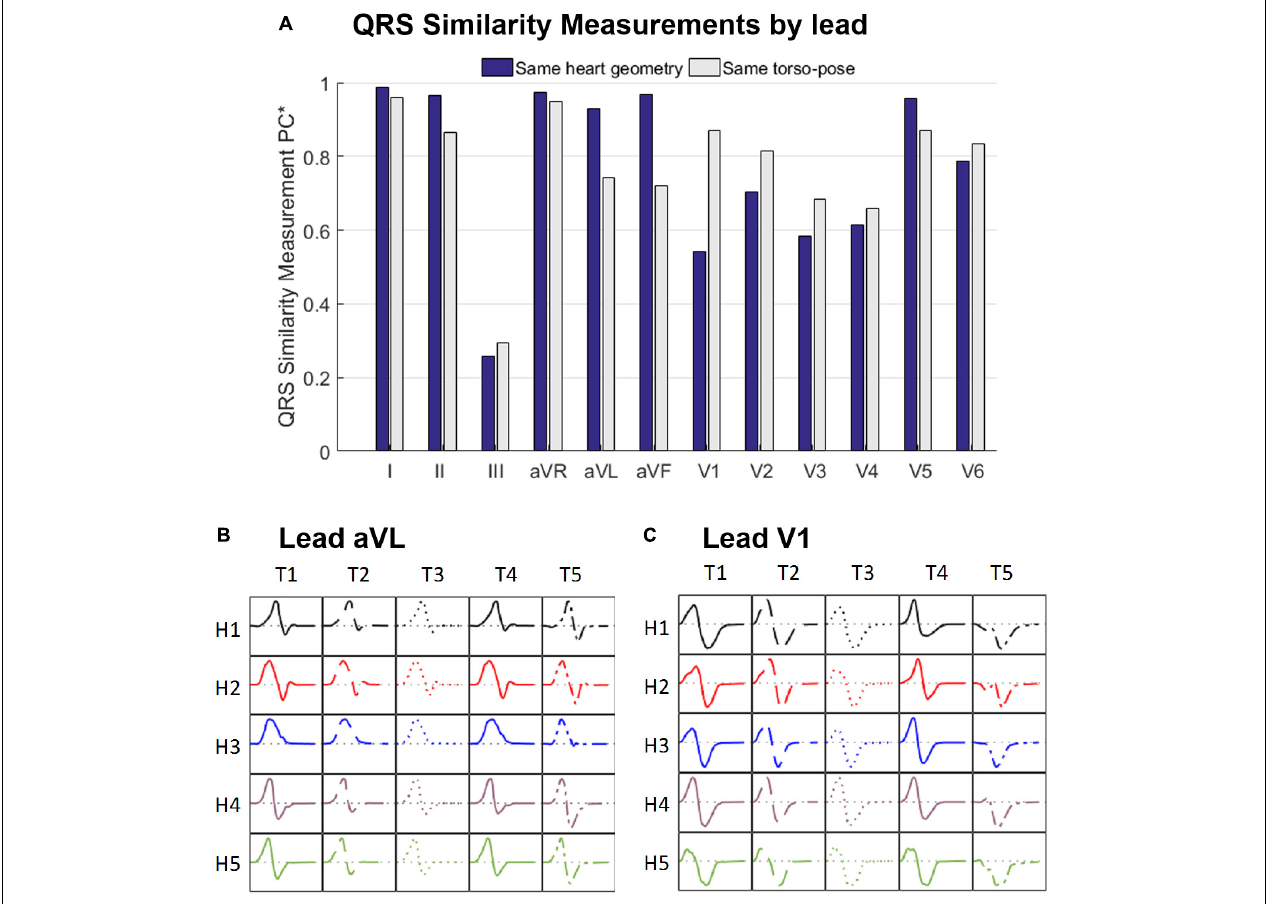
FIGURE 5 | (A) Similarity measurement (PC ∗ ) of the simulated QRS morphologies for fixed ventricular geometry (and varying torso-pose) (blue), and for fixed torso-pose (and varying ventricular geometry (gray). Panels (B,C) Simulated QRS morphologies obtained with the five ventricular geometries (H1 to H5) placed in the five torso-poses (T1 to T5) for leads aVL (B) and V1 (C)